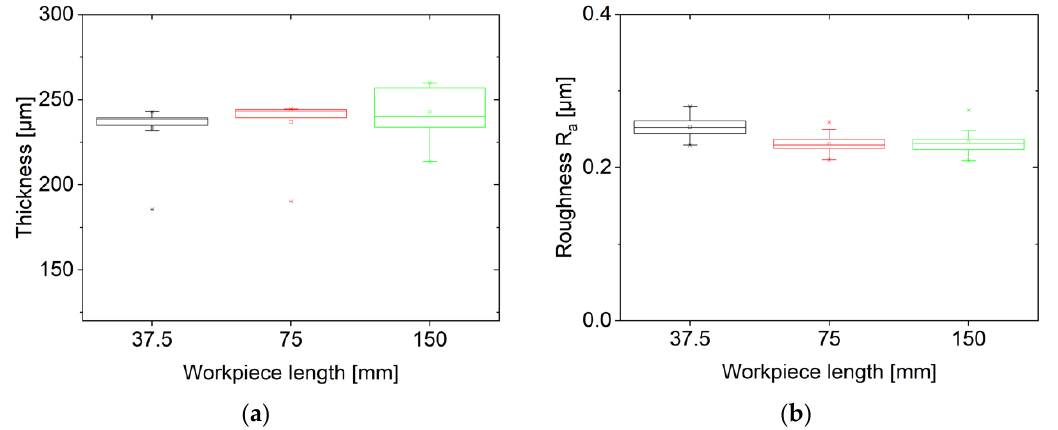
Figure 7. ( a ) Thickness variation for different workpiece lengths, ( b ) roughness values for different workpiece lengths.